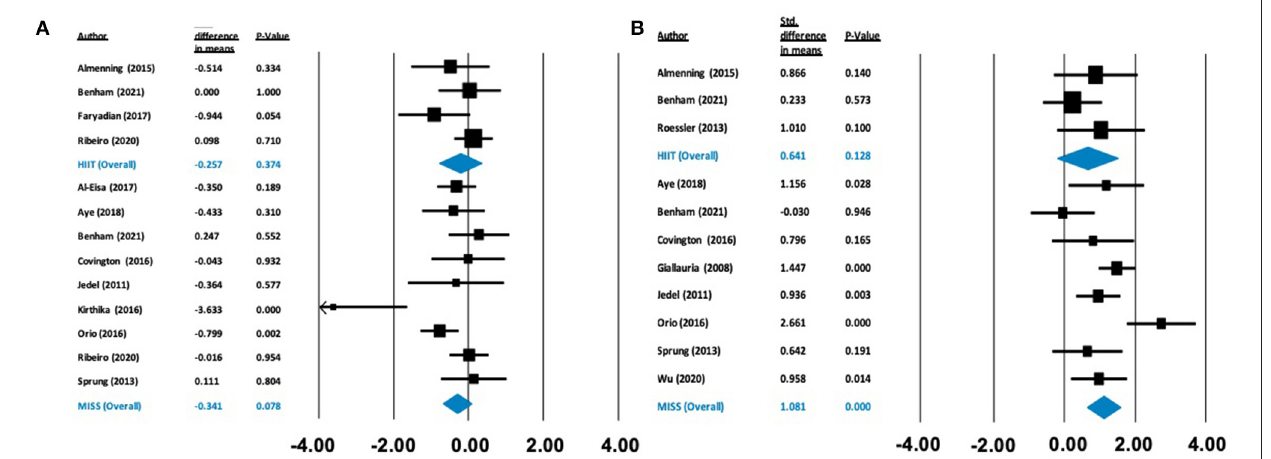
FIGURE 2 | Forest plots of standard difference in means 95% confidence intervals for the effect of high-intensity interval training (HIIT) and moderate intensity ± steady state exercise (MISS) on (A) HOMA-IR as a measure of insulin resistance, and (B) maximal oxygen consumption (VO 2max ) as a measure of cardiorespiratory fitness, in polycystic ovary syndrome. Filled squares represent study outputs. Lines represent 95% confidence intervals. Filled blue diamonds represent the weighted mean determined through meta-analyses.